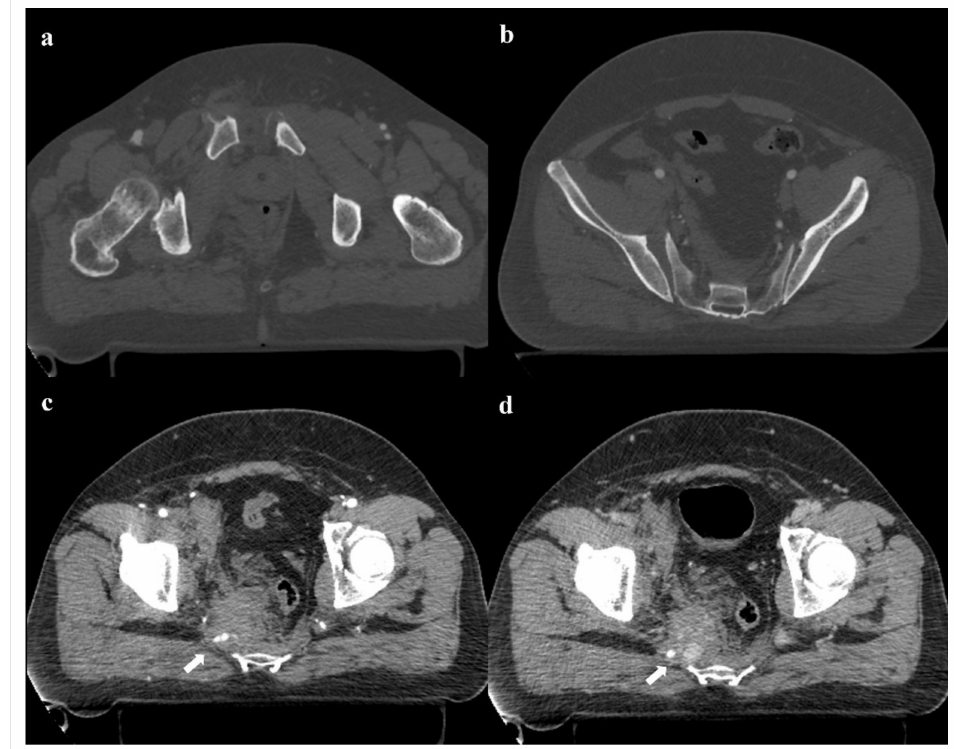
Figure 11. Axial CT images show a pubic symphysis diastasis of 2.9 cm, and an anterior widening of the right sacroiliac joint ( a , b ). Active extravasation of contrast medium in the arterial phase of the CT exam is seen near the right side of the fifth sacral vertebra (arrow in ( c )). The extravasation increases in the next phase of the examination (arrow in ( d )). This is acute arterial bleeding from a branch of the right inferior gluteal